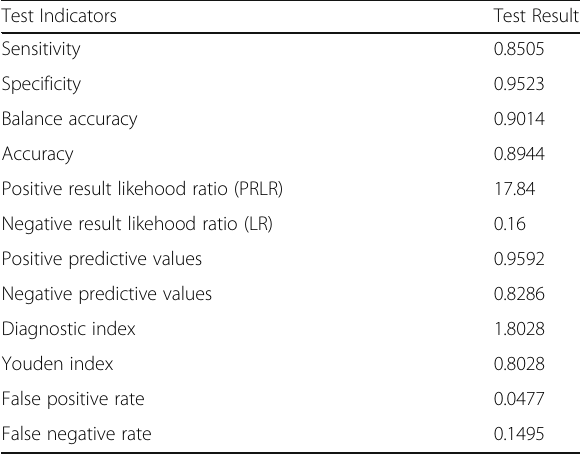
Table 2 Test Results of breast IDC identification based on whole slide